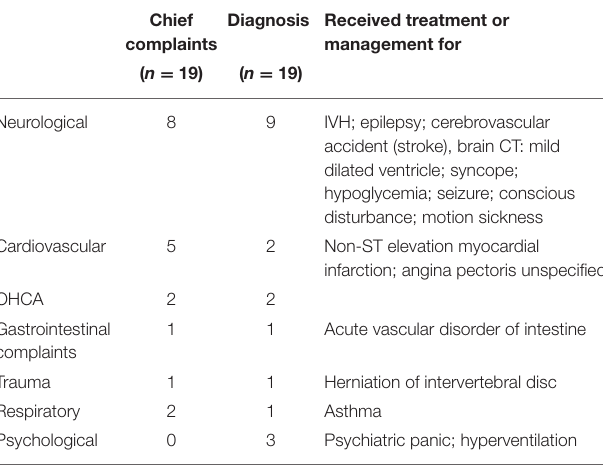
TABLE 2 | Chief complaints requiring unscheduled emergency landing, including flight-diversion/ re-entry, and final diagnosis and treatment provided. Chief Diagnosis Received treatment or complaints management for